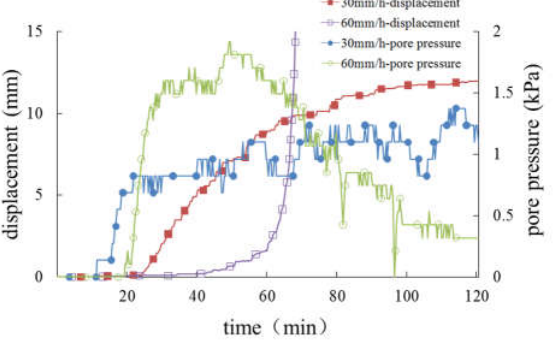
Figure 20. Curves of displacement and pore pressure in the slope with a weak layer of 10 cm.